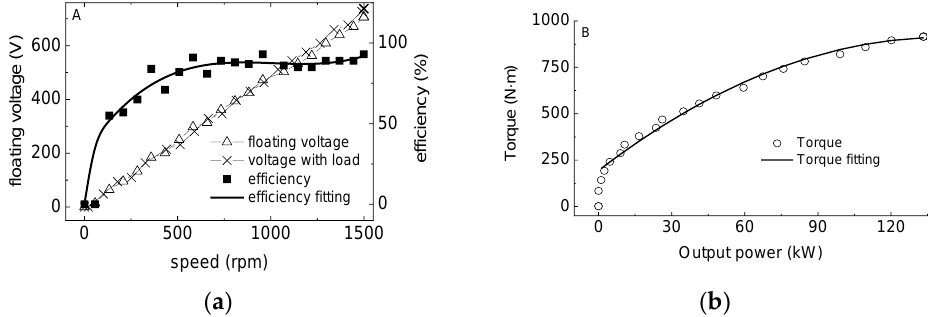
Figure 6. Results of the generator performance test: ( a ) speed; ( b ) output